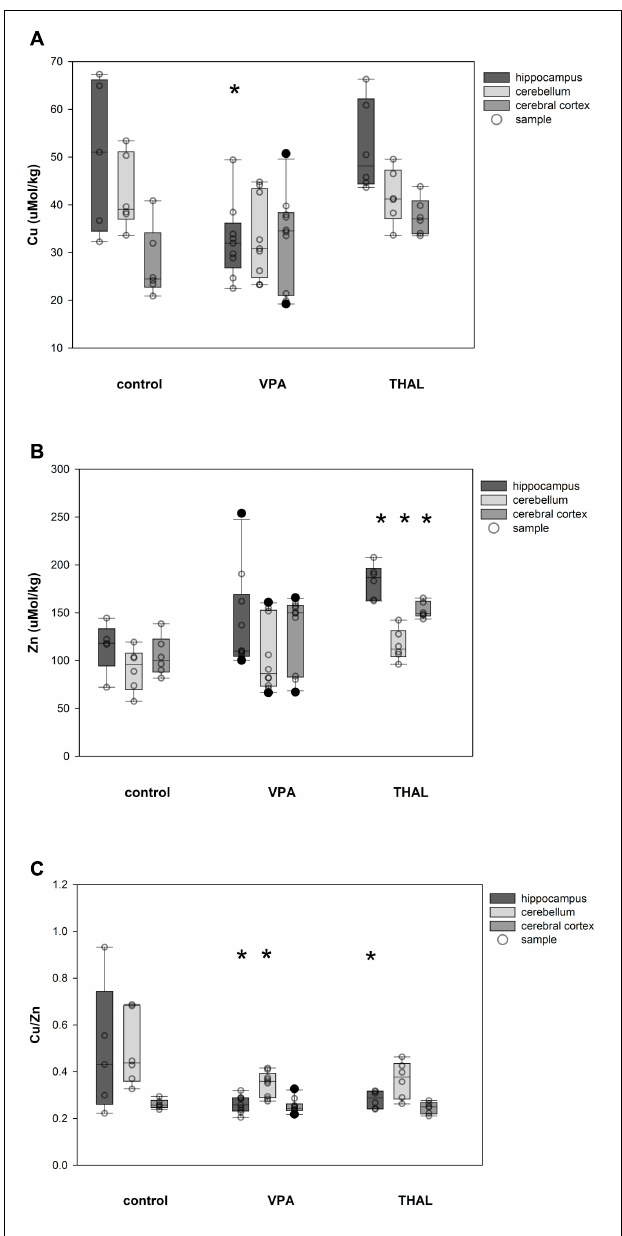
FIGURE 3 | Box and Whiskers plot of changes in Cu (A) , Zn (B) , and Cu/Zn (C) levels in female rats in parts of brain: hippocampus, cerebellum and cerebral cortex, measured using the ICP-MS method. The obtained results are expressed in concentration µ M/kg wet tissue (A,B) . The number of animals used in this experiment was: n = 6 – control group, n = 9 – VPA-treated rats, and n = 6 – THAL-treated animals; (*) represents results statistically significant vs. control, p < 0.05, two-way ANOVA followed by Holm-Sidak corrections; box containing 50% of results that fell in the range between 25% (bottom line) and 75% (top line) – IQR (InterQuartile Range), ( • ) median value, whiskers – min and max values, ( ◦ ) – outliers ( ± 1.5 × IQR), (–) – individual sample.